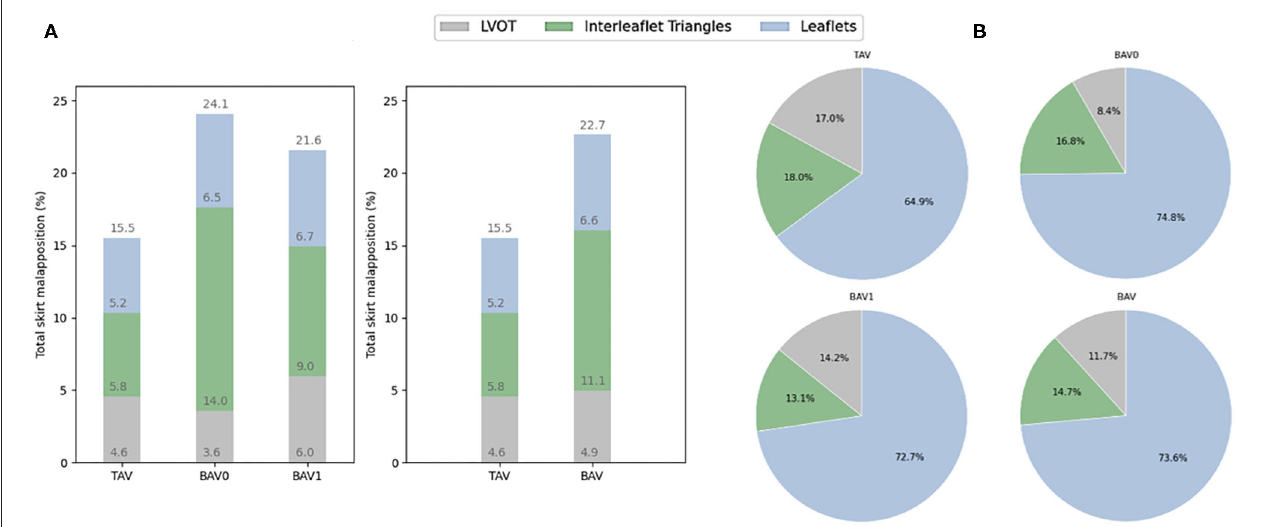
FIGURE 7 | (A) Contribution of each anatomical section to the malapposition (mean, %) of the total skirt. (B) Contribution of each anatomical section to the apposition (mean, %) for the apposed section of the skirt. All these values are presented for the different types of valve morphologies: TAV, BAV, BAV0, and BAV1. TAV, tricuspid aortic valve; BAV, bicuspid aortic valve; BAV0, type 0 bicuspid aortic valve; BAV1, type 1 bicuspid aortic